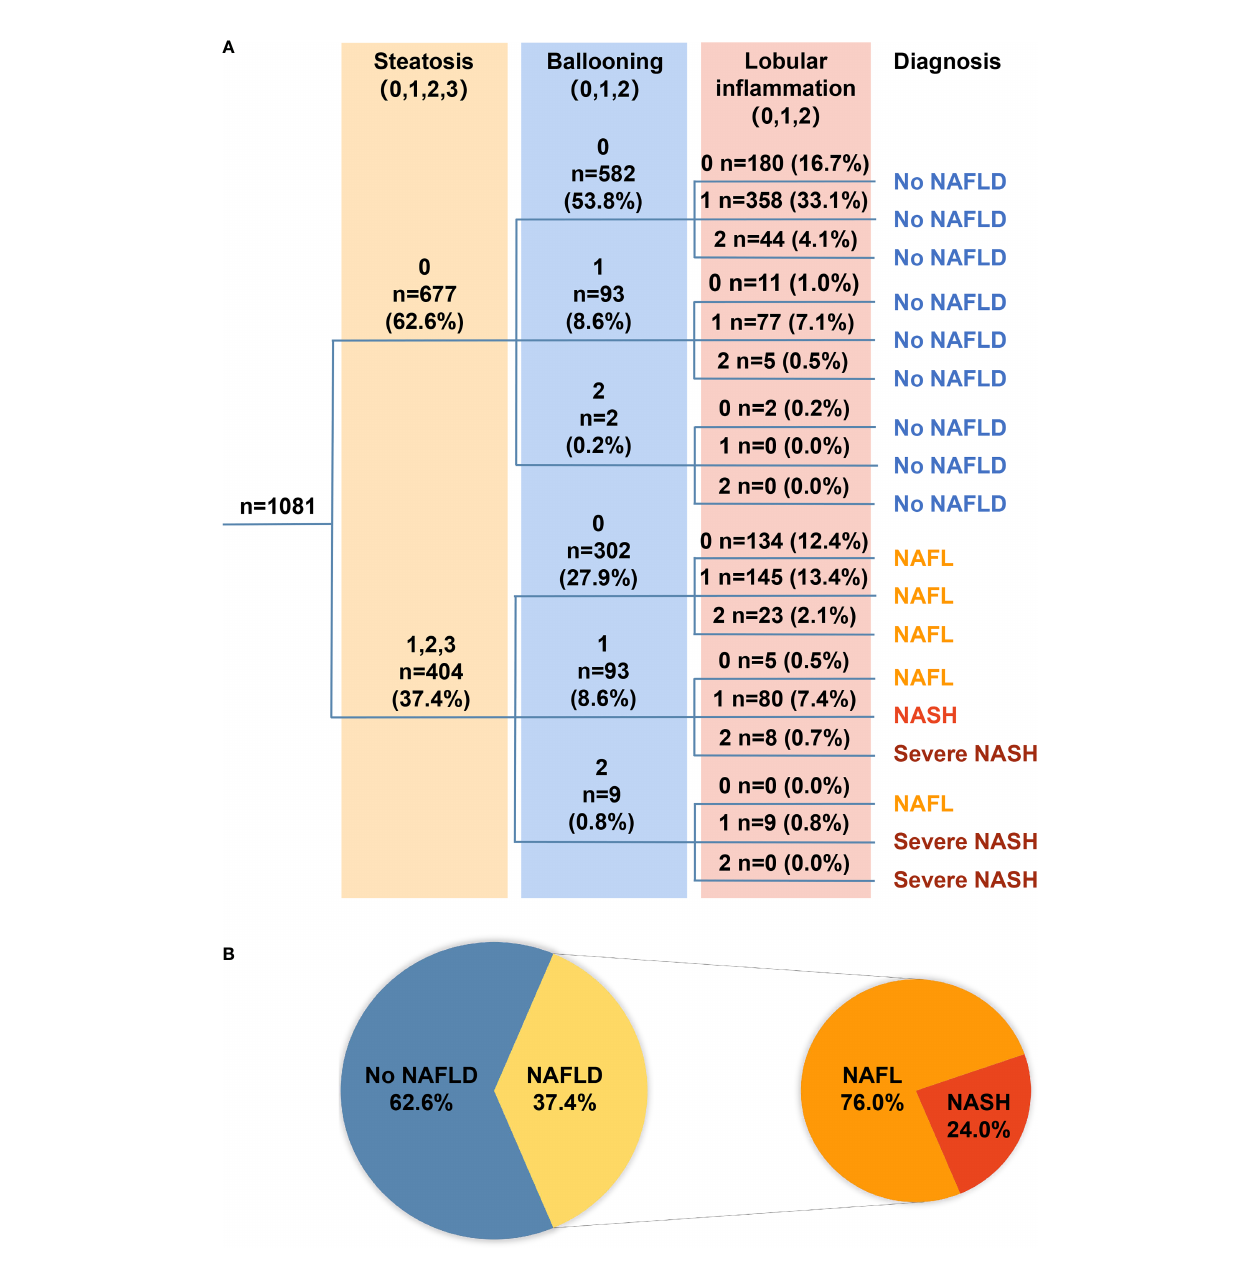
FIGURE 1 | (A) The FLIP algorithmic tree. A total of 1,081 patients with treatment-naïve chronic hepatitis B were classi fi ed into no NAFLD, NAFL, NASH, or severe NASH according to the FLIP algorithmic pathways based on the grade of steatosis [ (A) ; light yellow shade], grade of ballooning [ (B) ; light blue shade], and grade of lobular in fl ammation [ (A) ; pink shade]. Number of patients and the proportion among each category were presented as number (%). (B) Pie chart illustrates the proportion of patients with speci fi c diagnoses. Among all 1,081 patients, 62.6% had no NAFLD, and the remaining 37.4% had NAFLD, among whom 76.0% had NAFL and 24.0% had NASH. FLIP, fatty liver inhibition of progression; NAFLD, non-alcoholic fatty liver disease; NAFL, non-alcoholic fatty liver; NASH, non-alcoholic steatosis